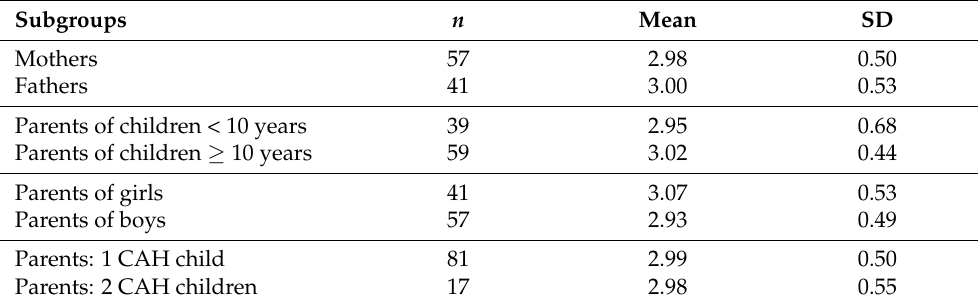
Table 5. Parental Quality of Life (ULQIE total score)—Subgroup